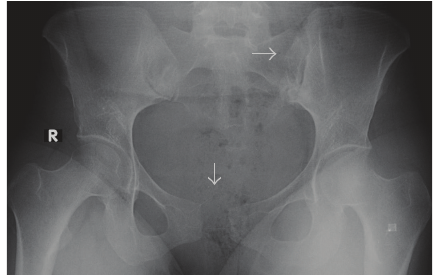
Figure 1: Anteroposterior radiograph of the pelvis demonstrating gross disruption of the pubic symphysis, with a separation of 2.4 cm and disruption of the left sacroiliac joint.